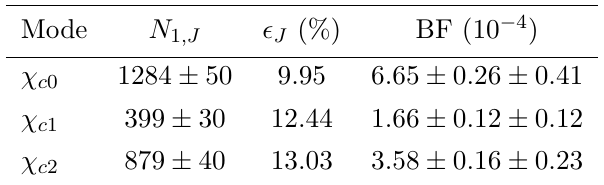
Figure 4 . Dalitz plots of M 2 the data sample. The signal regions of M [3 . 54 , 3 . 57] GeV/ c 2 , respectively.